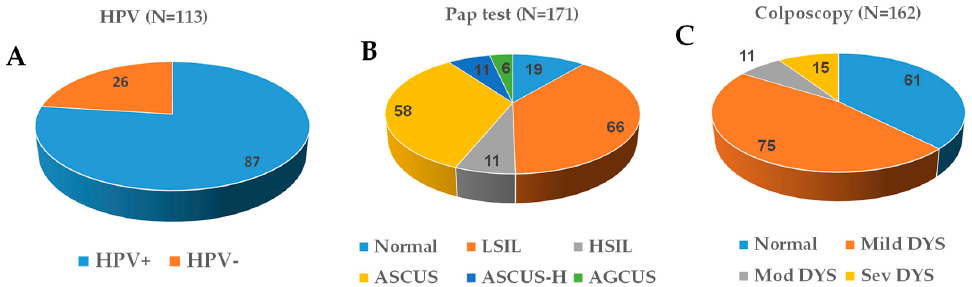
Figure 1. Data outcome of 173 cases that underwent human papilloma virus (HPV)/Pap testing and colposcopic examination. Individual pie charts indicate the frequency of women positive or negative for high-risk HPV infection ( A ), normal or abnormal Pap ( B ) and colposcopic ( C ) findings. N: total number of informative cases. LSIL: low-grade squamous intraepithelial lesion; HSIL: high-grade squamous intraepithelial lesion; ASCUS: atypical squamous cells of undetermined significance; ASCUS-H: atypical squamous cells, cannot exclude HSIL; AGCUS: atypical glandular cells of undetermined significance; Mod DYS: moderate dysplasia; Sev DYS: severe dysplasia. Table 1. Association between HPV status and outcome from Pap test, colposcopic evaluation and various socio-demographic factors. HPV 3 OR(95%CI) 4 p -value Factor Outcome Positive N (%) Negative N (%)